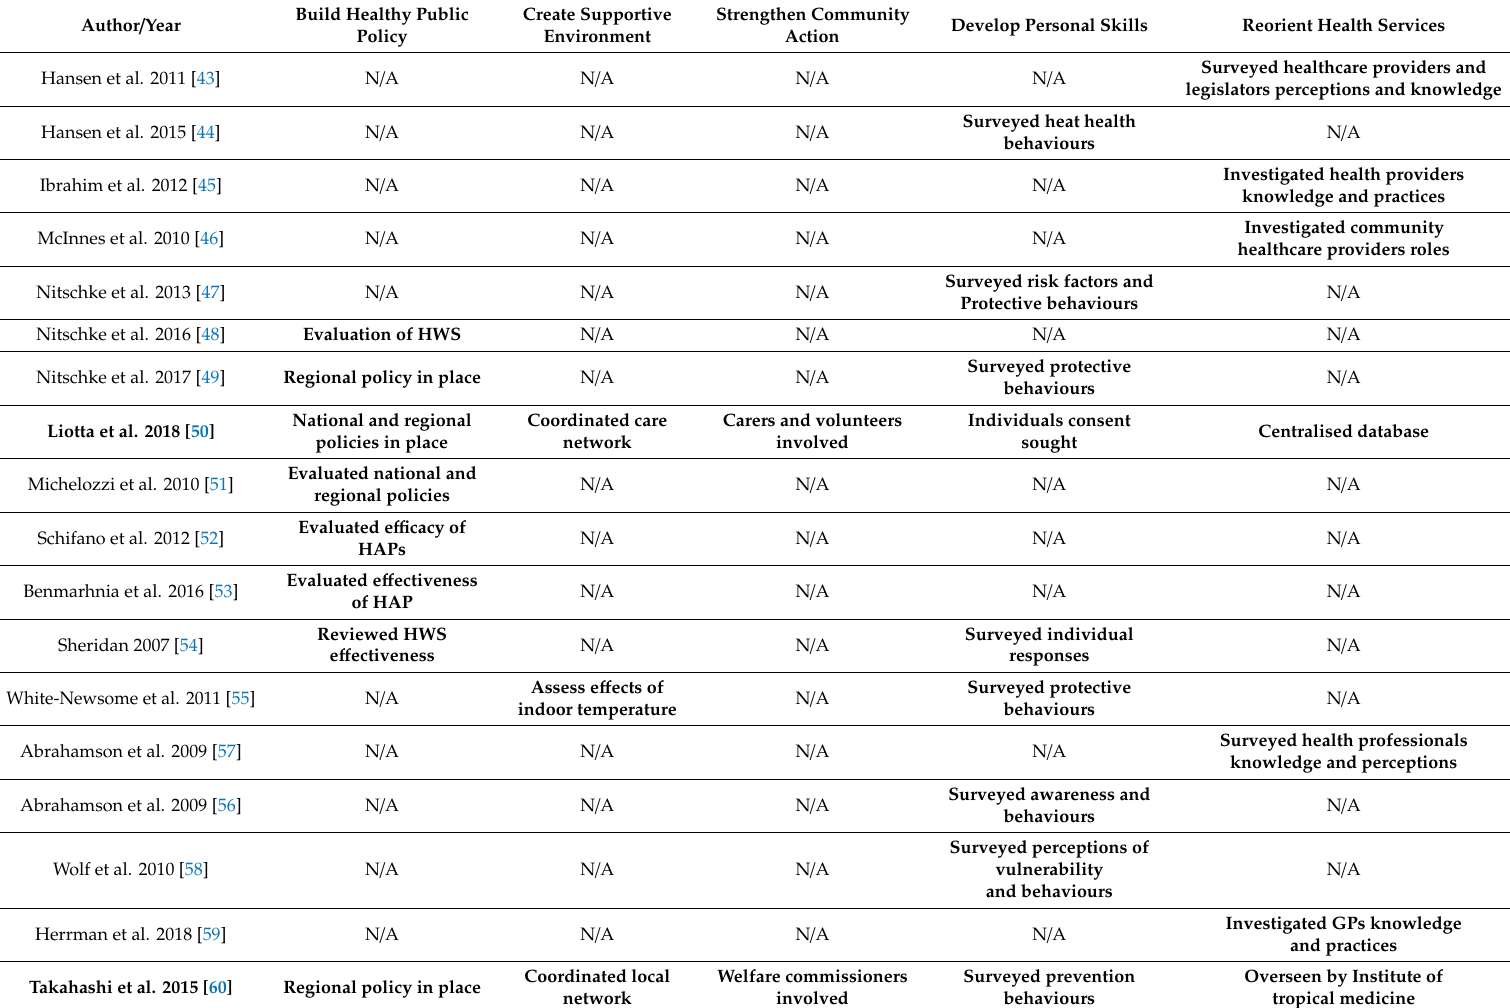
Table 3. Ottawa charter action